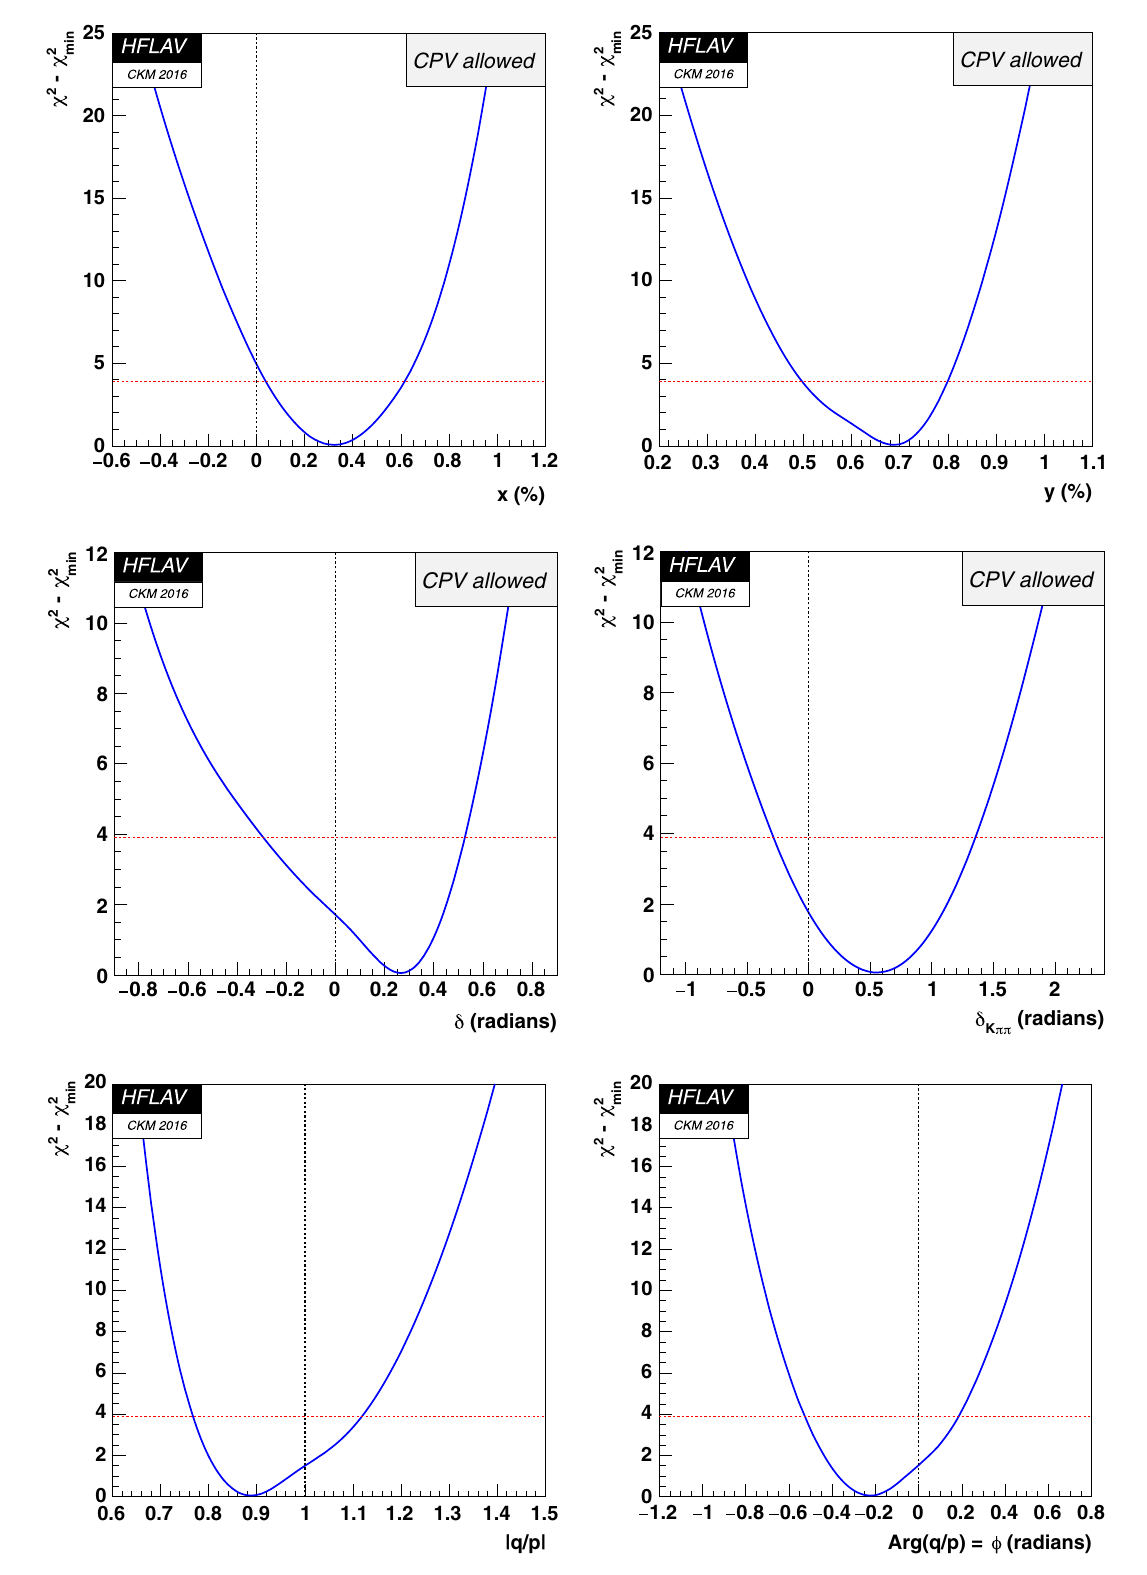
, | q / p | , and φ . The points where (cid:5)χ 2 = 3 . 84 (denoted by dashed for fitted parameters x , y , δ, δ K ππ min